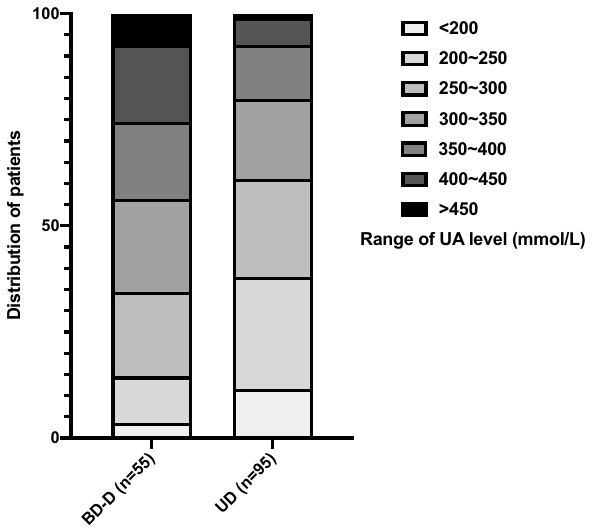
Figure 3. Distribution of patients in UA interval (every 50 μmol/L of UA change). UD group included the higher percent of patients with high level of UA than BD-D subgroup. BD-D, bipolar depression; UD, unipolar depression; UA, uric